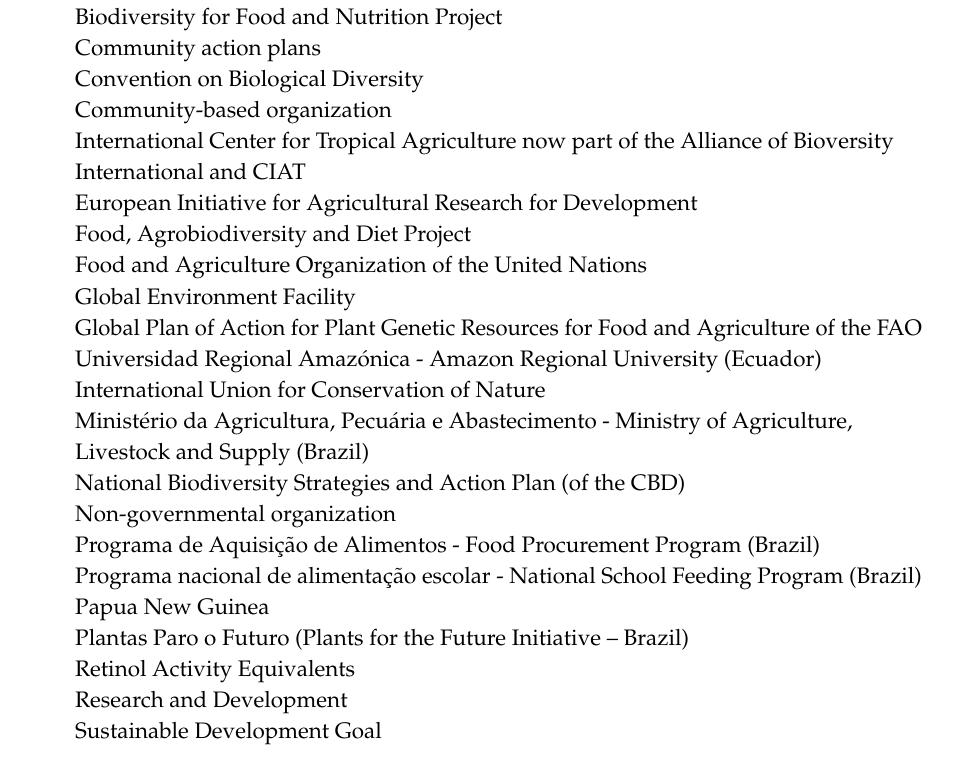
Table S1: Plant families that include WFPs and semi-cultivated species that are known to contribute to food and nutrition security; Table S2: Summary of actions that can be undertaken across the four pillars by the main stakeholders involved in WFP conservation and